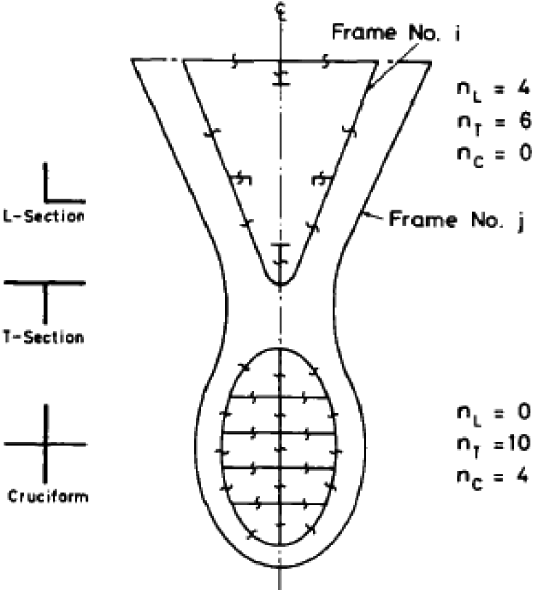
Fig. 2. Cross-section of the bow with basic structural sections [8].